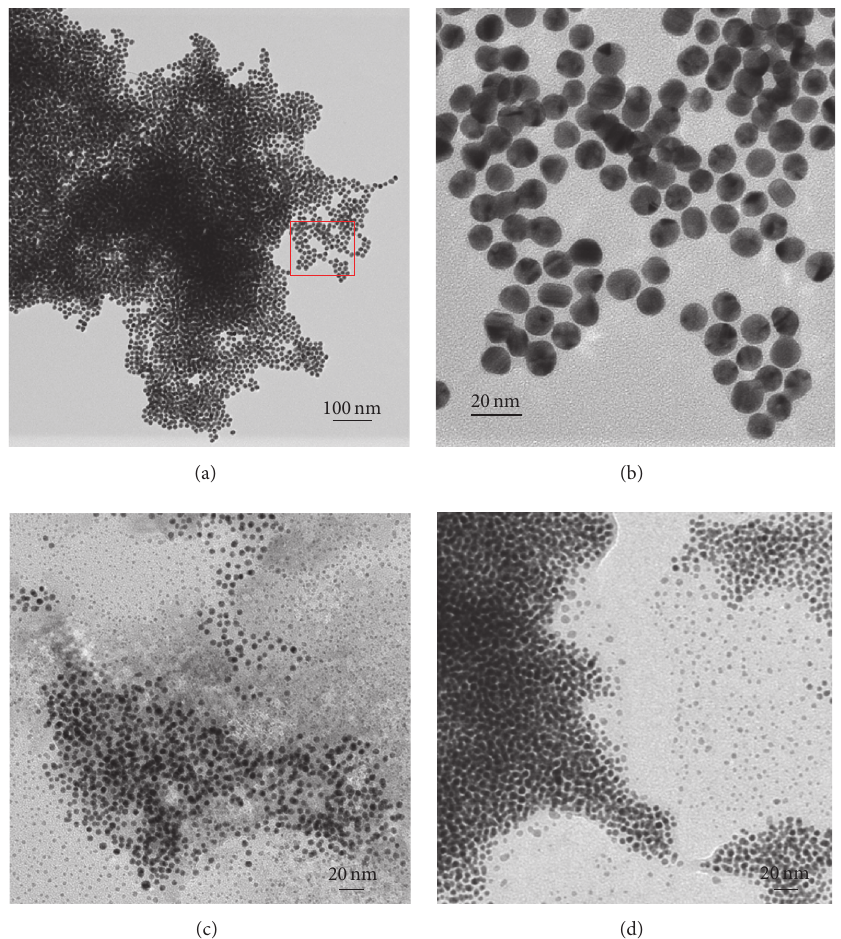
Figure 1: TEM imaging of functionalized and hybridized 13nm Au NPs and hybridized 4nm Au NPs. (a) Hybridized 13 nm Au A1 + C1 NPs. (b) Higher magnification TEM image of the boxed area in (a). (c) Hybridized 4nm Au A1 + C1 NPs. (d) Hybridized 4nm Au A1-pA + C1-pA